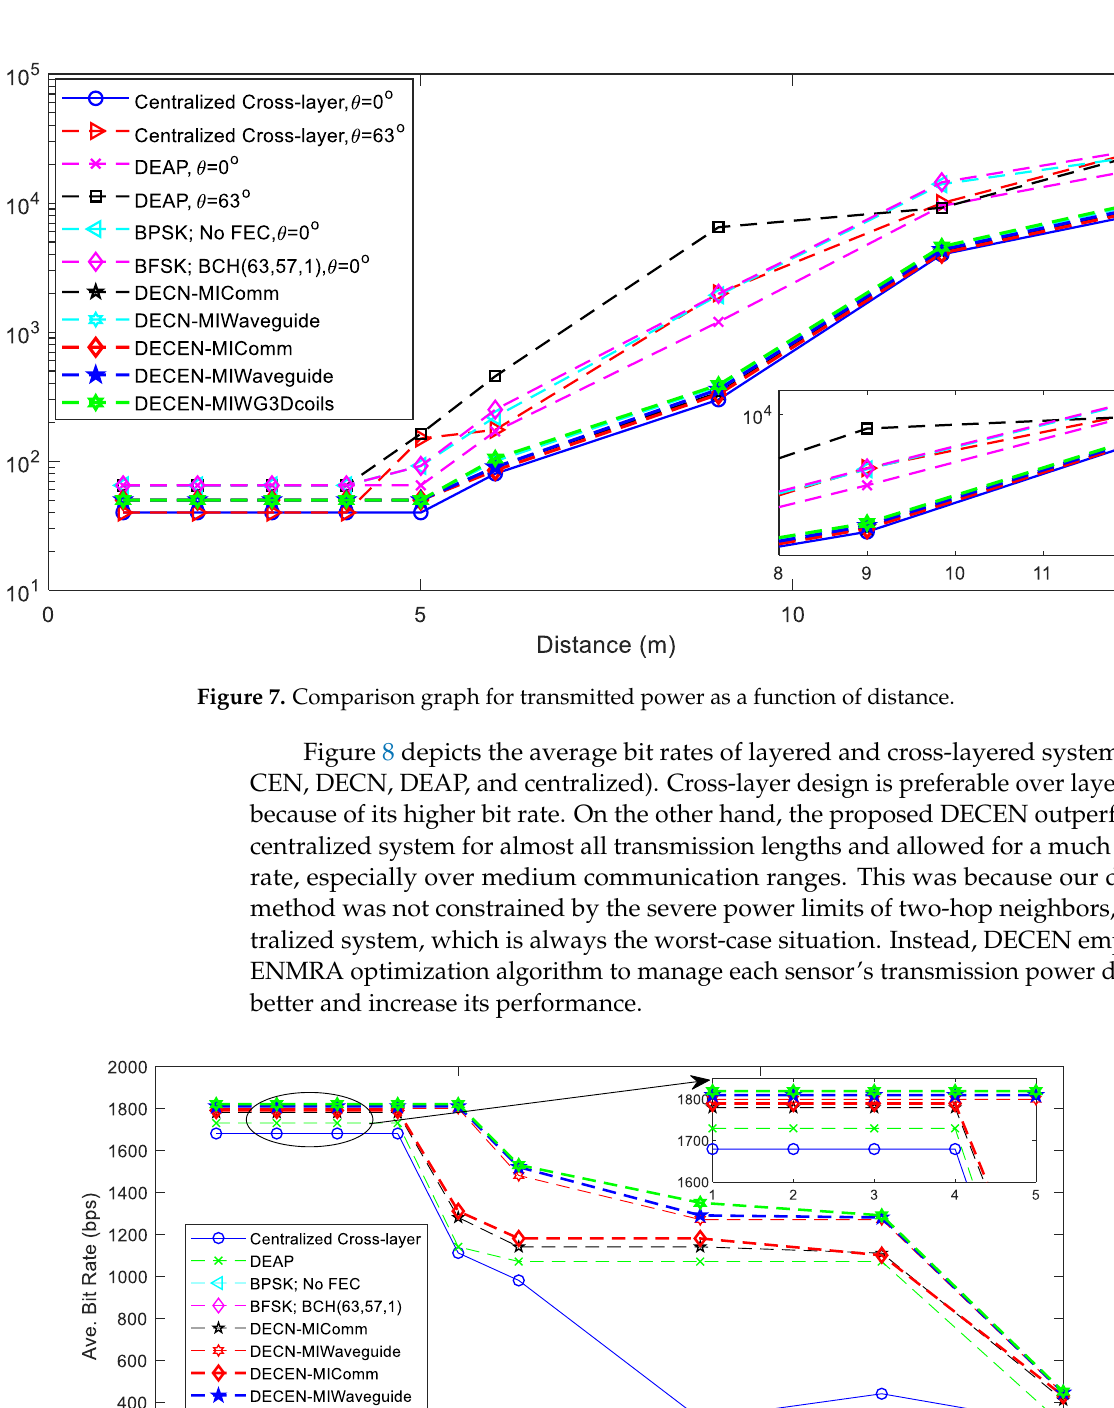
Figure 6. Comparison graph for transmitted energy as a function of distance.